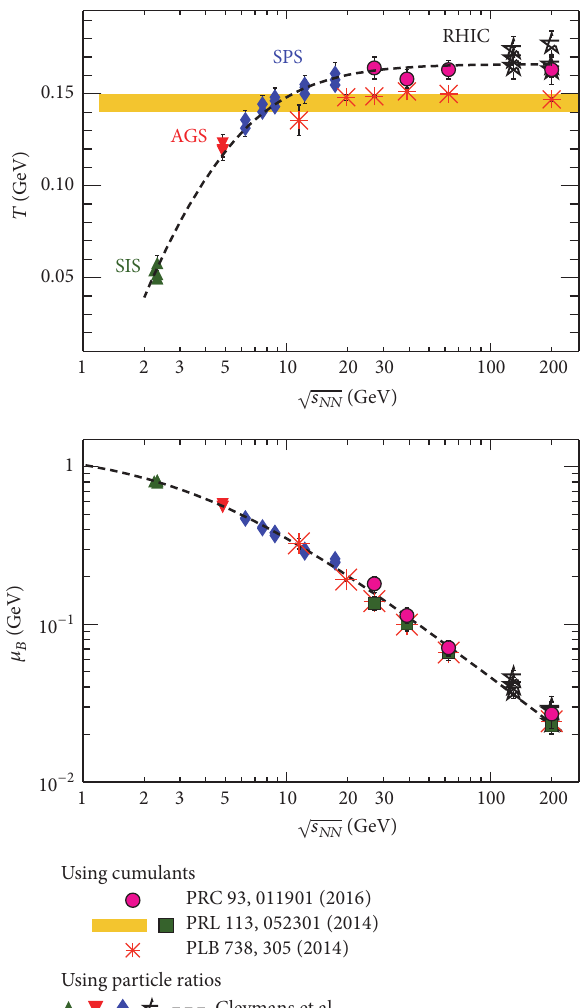
Figure 10: The energy dependence of the chemical freeze-out temperature ( 𝑇 𝑓 ) and baryon chemical potential ( 𝜇 𝐵 ) extracted using lattice calculations with experimental measured cumulants [38, 65]. The freeze-out parameters extracted using HRG and experimental cumulants are also shown [39]. The dashed line is the parameterization given in [77], and the SIS, AGS, SPS, and RHIC data are from [77] and references